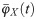
Exact stochastic simulation of the Drosophila circadian clock system.(A) A stochastic trajectory obtained by running the SSA over the time-interval t ∈ [0, 8.5τ] and (B) SSA samples (R = 3000) at times t = τ, 2τ, …, 8τ. The concentrations, X(t) = Y(t)/Ω, of two (out of 10) of the species are displayed (per mRNA MP (x-axis) and nuclear PER-TIM complex CN (y-axis)). For this model the system size Ω is Avogadro’s number in units of nM−1 multiplied by the cell volume in litres and the concentrations are nanomolar. The value of Ω used here is 300 in units of nM which assumes a cell volume of approximately 0.5 × 10−12 litres. The number of MP molecules ranges from 0 to 1200 and the number of CN molecules from 100 to 900. It is only through Ω that the cell volume appears in the equations. The black solid curve is the Ω → ∞, limit cycle solution. (C) Schematic diagram illustrating the mapping GN(⋅) and the relative phase δφX(⋅). (D) A plot of the lifted phase function φ¯X(t) for a trajectory of this system. Note the long-term linear increase combined with frequent reversals.